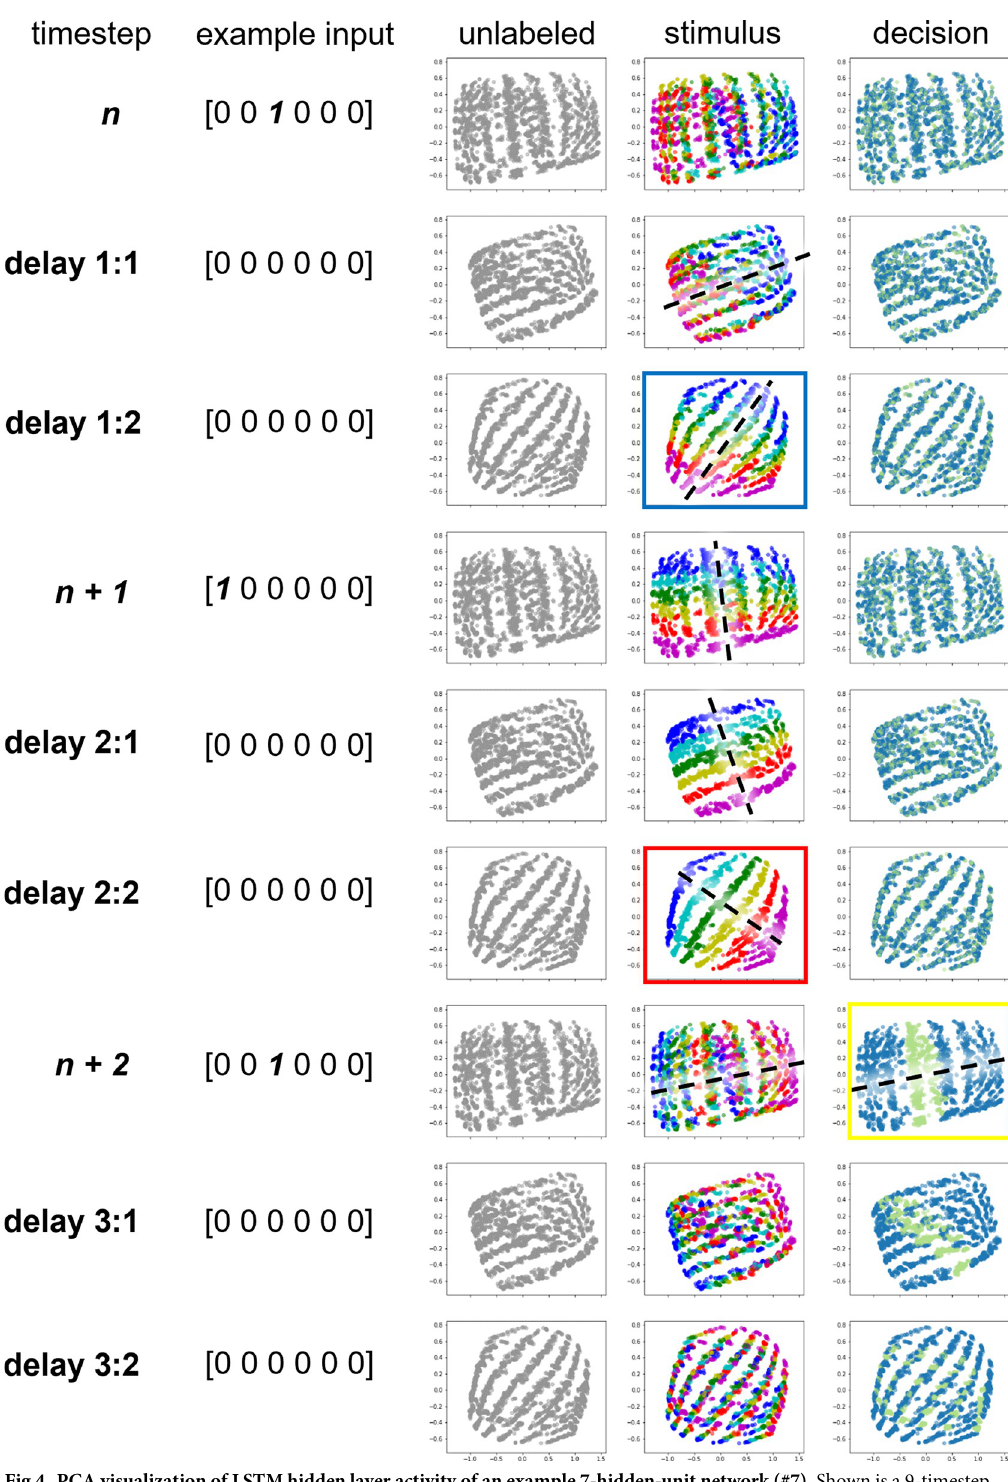
Fig 4. PCA visualization of LSTM hidden layer activity of an example 7-hidden-unit network (#7). Shown is a 9-timestep time course of the 2-back task, running from stimulus n to delay 3 : 2 . Column 1 and 2: timestep labels and example input vectors. Column 3: Time course of dimensionality-reduced LSTM hidden layer activity. Each dot in the figures indicates the unit activity from a single trial. Column 4: Same as Column 3 but now each color corresponds to one of the six stimulus types, indicating stimulus n ’s identity, and the black dashed lines illustrate the “schematic” stimulus coding axis. Blue and red